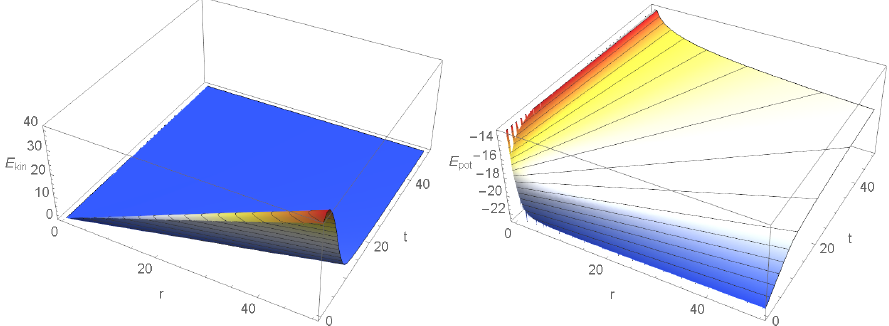
Figure 5. The kinetic and potential energy densities of the investigated fluid for w = − 1, with initial conditions f ( 10 − 3 ) = 0.5 and g ( 10 − 3 ) =